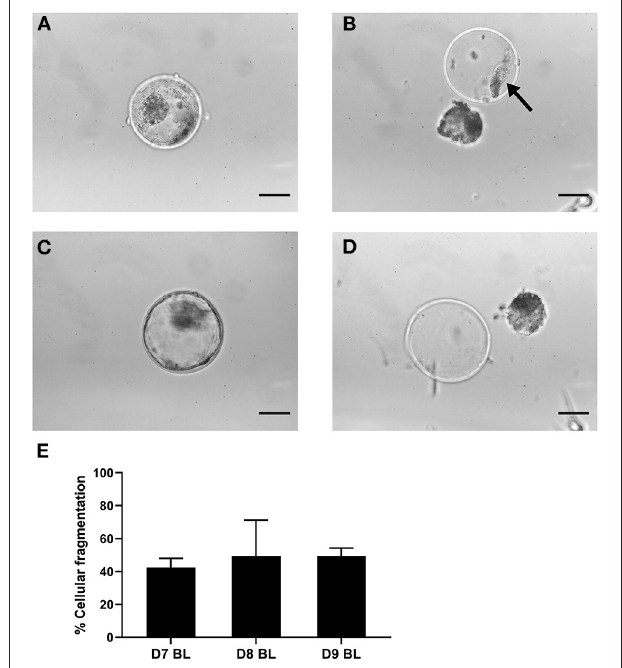
FIGURE 2 | Cellular fragments in the zona pellucida of expanded blastocysts. Representative expanded blastocyst with cellular fragmentation before (A) and after (B) mechanically induced hatching. Representative expanded blastocyst without cellular fragments before (C) and after (D) mechanically induced hatching. Arrow indicates cell fragments. (E) Graph indicating percentages of blastocysts with cellular fragments in the zona pellucida after 7 ( n = 140), 8 ( n = 155), 9 ( n = 148) days of in vitro culture. Error bars indicate standard deviation of three biological replicates. Scale bar = 50 µ m. D, day; BL,